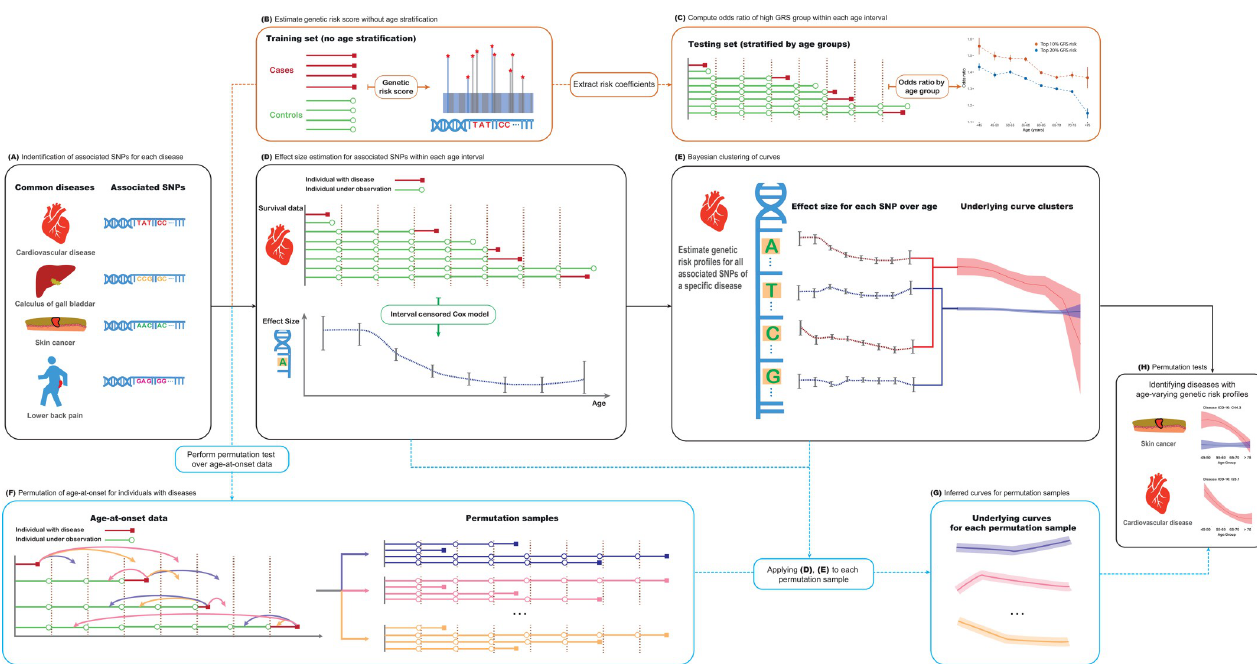
Fig 1. Schematic representation of methodology. (A) Independent variants associated with a trait of interest are identified by analysis of the entire UK Biobank cohort using the TreeWAS methodology [40]. (B) Logistic regression is applied to estimate coefficients for variants on each trait using the training set. (C) Coefficients are used to compute individual genetic risk scores; the odds ratio associated with high GRS within each age group are estimated in the testing set. (D) An interval-censored proportional hazards model [44] is used to estimate the effect (and associated standard error) of each variant on the trait of interest within each of eight age intervals. (E) Bayesian clustering is used to estimate population age-profiles of risk, using either linear models or quadratic polynomials to encourage smoothness. (F-H) Permutation is used to test for age-homogeneity of effect size as well as to assess the evidence for multiple age